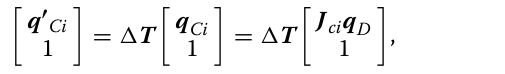
The kinematic constraint of the system is the deforma- tion coordination condition. Compared with the five fixed-length links, the moving platform can be regarded as a rigid body due to relatively larger rigidity. In this par- allel mechanism, the displacement of the hinge point of the fixed-length link connected to the moving platform